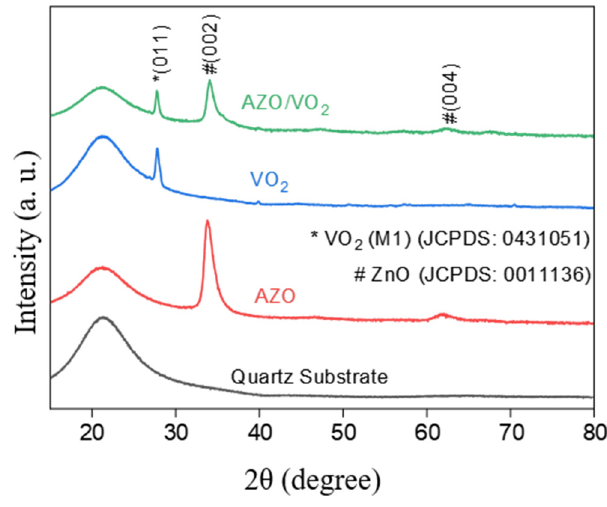
Figure 1. Room temperature GIXRD data of substrate, VO 2 , AZO and AZO/VO 2 thin film samples. After confirming the single-phase growth of VO 2 in single and AZO/VO 2 thin film samples, we have recorded the temperature-dependent GIXRD data of these samples fo- cused to M(011) diffraction peak in temperature range 28 to 90 °C. This enabled us to